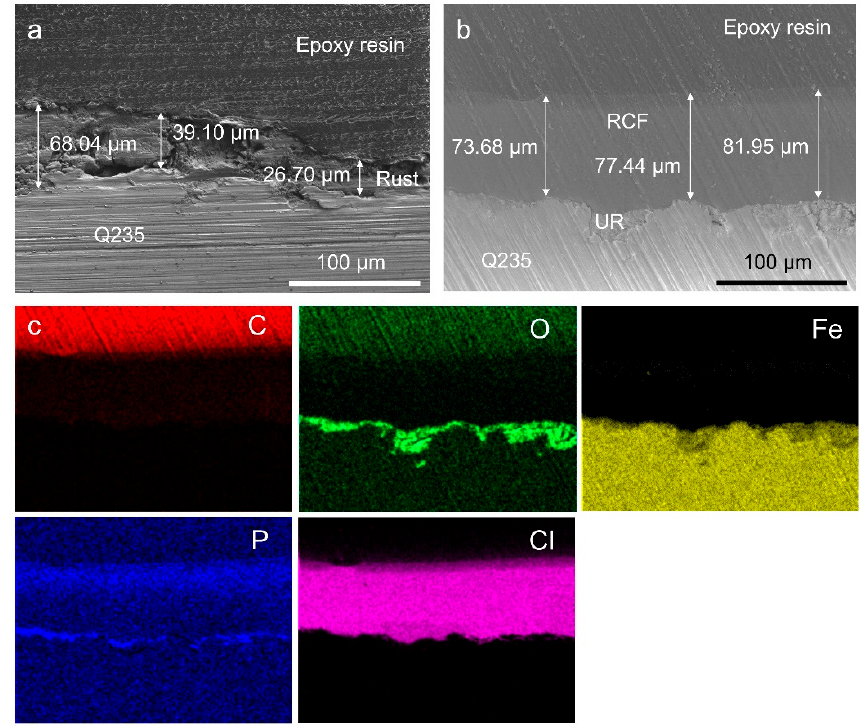
Figure 10. Cross-section micrographs of rusted steel before ( a ) and after ( b ) rust conversion treatment and the chemical mapping ( c ) of C, O, Fe, P, Cl belonging to ( b ) (RCF: Rust conversion film, UR: Unreacted Rust).